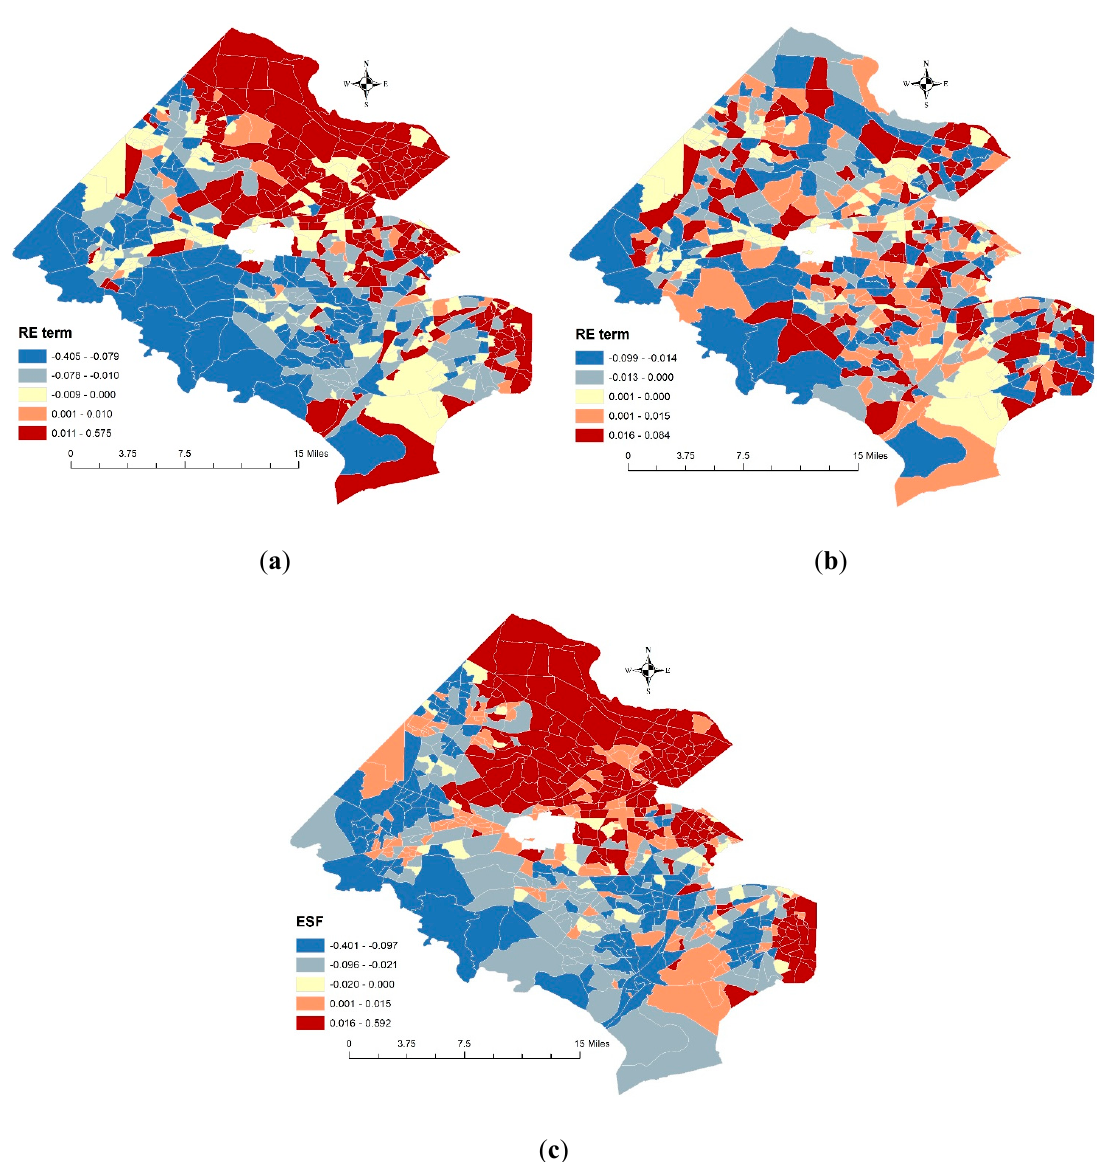
Figure 3. Estimated random effects (RE) and eigenvector spatial filtering (ESF) components. ( a ) The RE component from the multilevel model. ( b ) The RE component from the multilevel Moran eigenvector spatial filtering (MESF) model. ( c ) The ESF component from the multilevel MESF model.